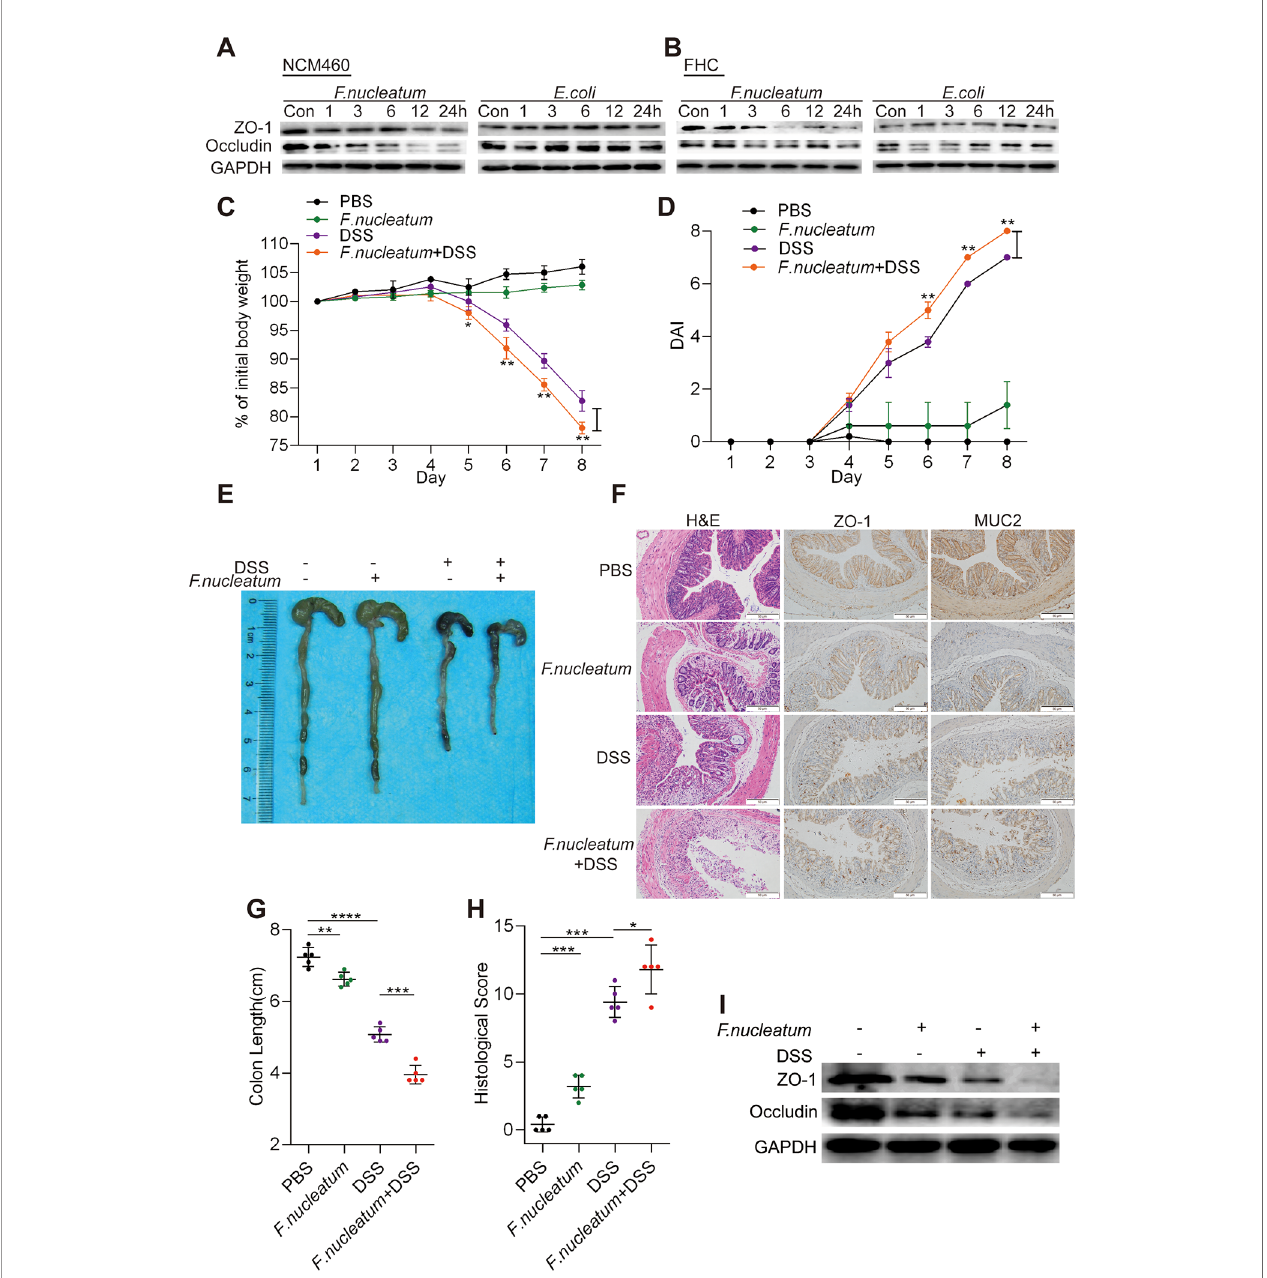
FIGURE 2 | Fusobacterium nucleatum destroys epithelial barrier function in vitro and in vivo. (A, B) Western blotting was performed to measure the expression of ZO-1 and occludin in NCM460 cells (A) and FHC cells (B) cocultured with F. nucleatum , Escherichia coli , or phosphate-buffered solution (PBS) (Control, Con). (C, D) Mice (n=5 per group) were administered F. nucleatum or PBS for 2 weeks and treated with 3% dextran sulfate sodium (DSS) for 7 days. Colitis induction was evaluated by body weight loss (C) and the disease activity index (DAI) (D) . (* p < 0.05, ** p < 0.01, and *** p < 0.001; one-way ANOVA combined with Bonferroni ’ s post hoc test; the error bars indicate the SDs). (E – G) Representative colon morphology and length in the mice are shown in panel (E) and quanti fi ed in panel (G) . The sections used for HE, MUC2, and ZO1 staining were from the same mouse in the same group and three sections of the same tissue were stained separately. Representative images of histological analyses are shown in panel (F) and quanti fi ed in panel (H) . Representative images of MUC2 and ZO-1 expression are shown in panel (F) (* p < 0.05, ** p < 0.01, and *** p < 0.001; unpaired Student ’ s t test; the error bars indicate the SDs; 200× magni fi cation). (I) Western blotting was performed to measure ZO-1 and occludin expression in mouse